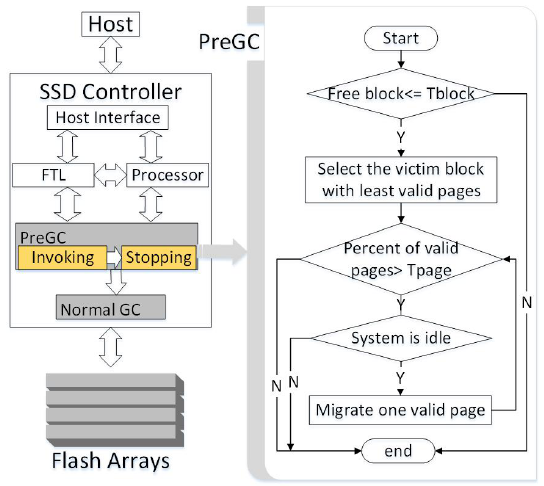
Figure 6. Overview of PreGC in 3D SSD controller. The Pregc mechanism is located in the SSD controller and works with the FTL, processor, etc., including the invoking module and the stopping module; the workflow of Pregc is shown on the